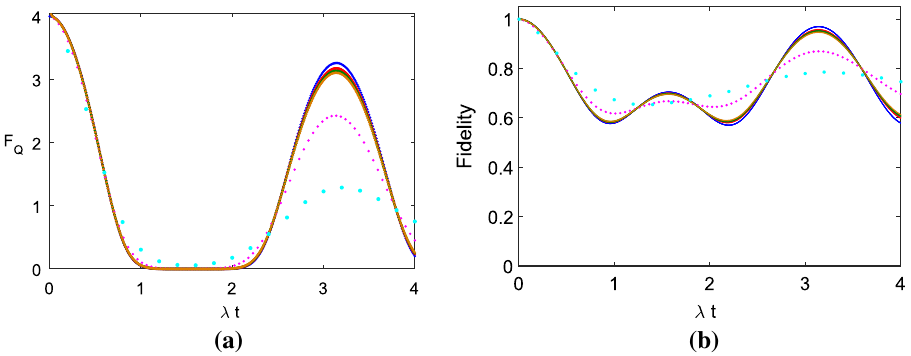
Figure 1. ( a ) QFI vs. (cid:31) t , ( b ) Fidelity vs. (cid:31) t , for N = 34 and n m = 903 (red), N = 28 and n m = 613 (green), N = 25 and n m = 488 (brown), N = 10 and n m = 78 (pink), N = 5 and n m = 20 (sky blue). Here D / (cid:31) = 0.01 and the maximal time is (cid:31) t m = 4 . Here we do not consider the d – d interaction and the collective decay of the atoms, i.e., g = γ = 0 , and the difference interval of the estimated phase is δφ = 0.0001 . In ( a , b ), blue lines indicate the curve got from the analytical expression, and the red, green, brown, pink, sky blue lines indicate the numerical simulation result got from this paper under the same parameters,